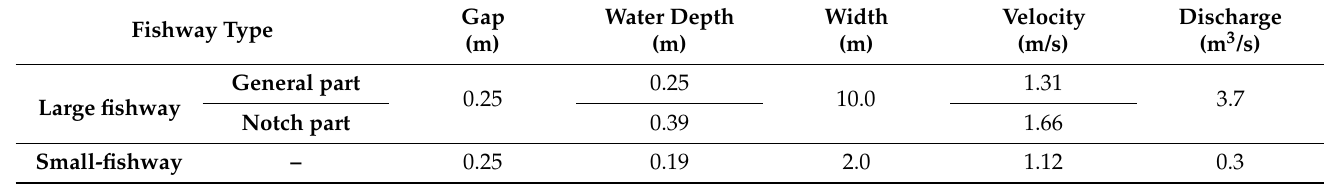
Table 1. Fishway specifications before improvement (from 1986 to 2011). Two fishways with different water depths and flow velocities were constructed at Miyanaka Intake Dam. The details are shown in Figure 2a.